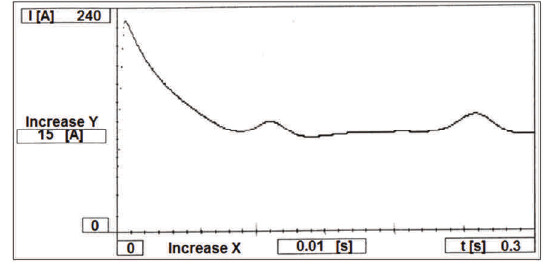
Fig. 6. Initial start-up phase